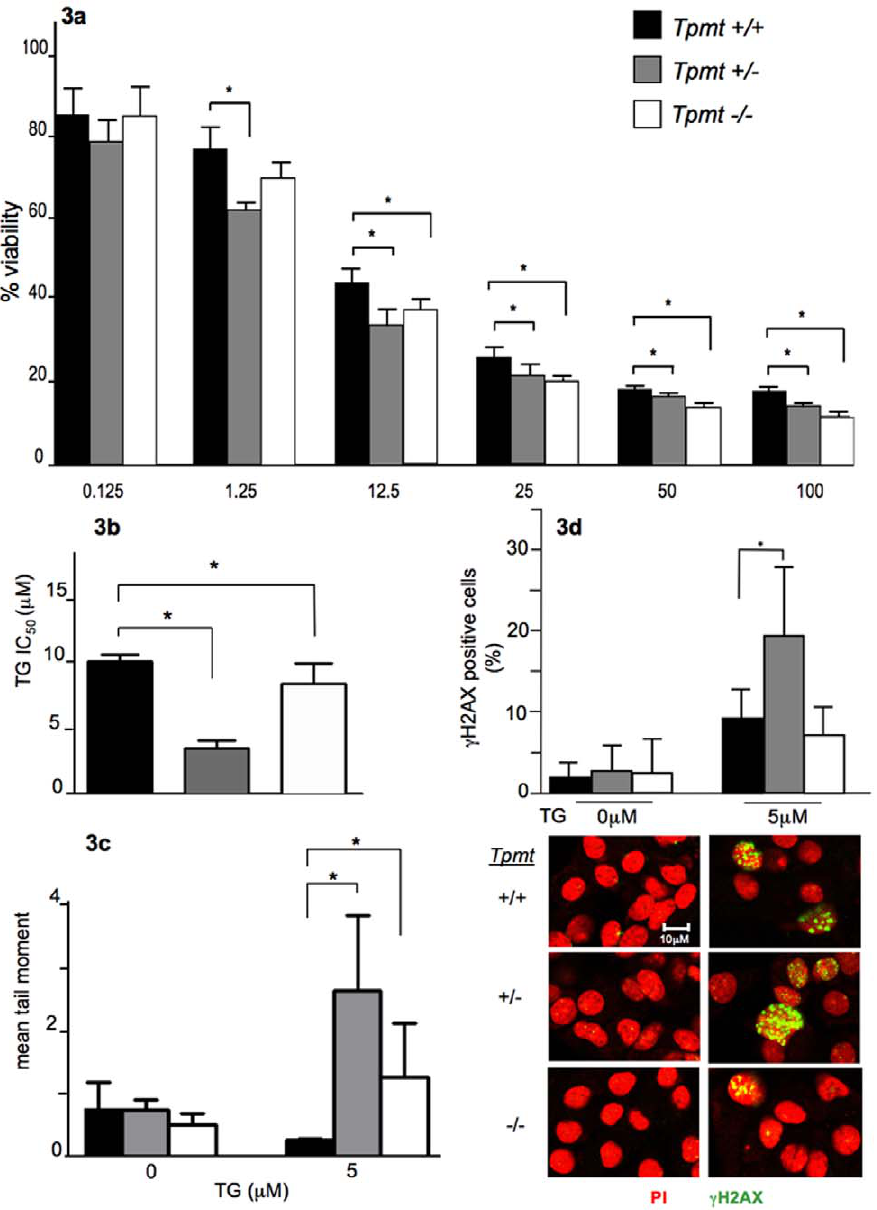
Figure 3. Comparison of thioguanine phenotypes in primary astrocyte cultures of each Tpmt genotype. (a) Primary astrocytes of each Tpmt genotype were exposed to thioguanine (TG) and cell viability was determined using the MTT assay. Tpmt + / 2 and Tpmt 2 / 2 astrocytes were significantly more sensitive to TG (12.5–100 m M) than Tpmt + / + (p , 0.04). (b) IC 50 values were significantly different between the three genotypes (p=0.027) and Tpmt + / 2 astrocytes were the most sensitive. (c) The alkaline comet assay was used to compare TG-induced DNA damage between genotypes. Tpmt + / 2 and Tpmt 2 / 2 astrocytes had significantly higher mean comet tail moments than Tpmt + / + astrocytes (p=0.033). (d) Immunoflourescence staining for c H2AX confirms IC 50 and comet data. Tpmt + / 2 astrocytes had greater damage than Tpmt + / + (p=0.03). Below are representative images of c H2AX staining for control treated (left) and TG treated (right) astrocytes. c H2AX foci stained in green; nuclei stained in red (Zeiss LSM 710 Laser Scanning Microscopes, 400 6 magnification). Bars represent the means; whiskers represent the standard deviation ( 6 ); * p , 0.05.